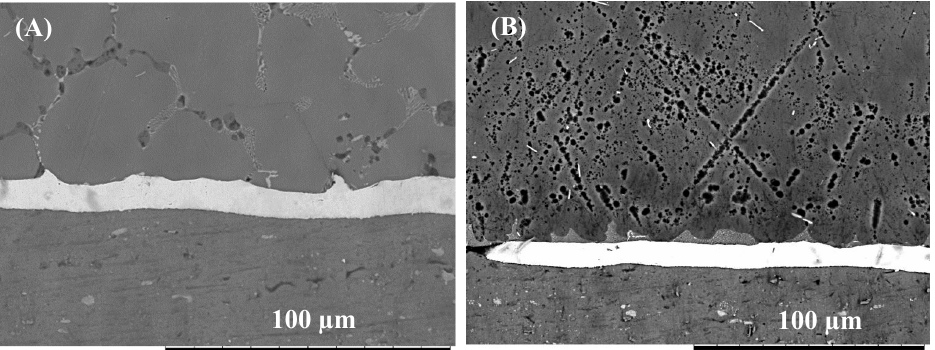
Figure 6. ( A ) SEM micrograph of the Mg/Al bonded for 2 min using Cu interlayer. ( B ) Mg/Al bonded for 5 min using pure-Cu interlayer.